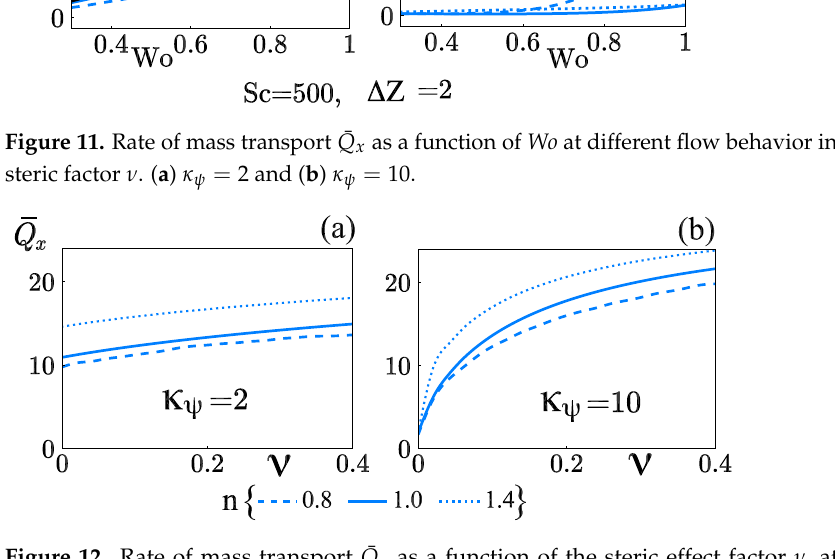
Figure 12. Rate of mass transport ¯ Q x as a function of the steric effect factor ν , at different flow behavior indices n . ( a ) κ ψ = 2 and ( b ) κ ψ =